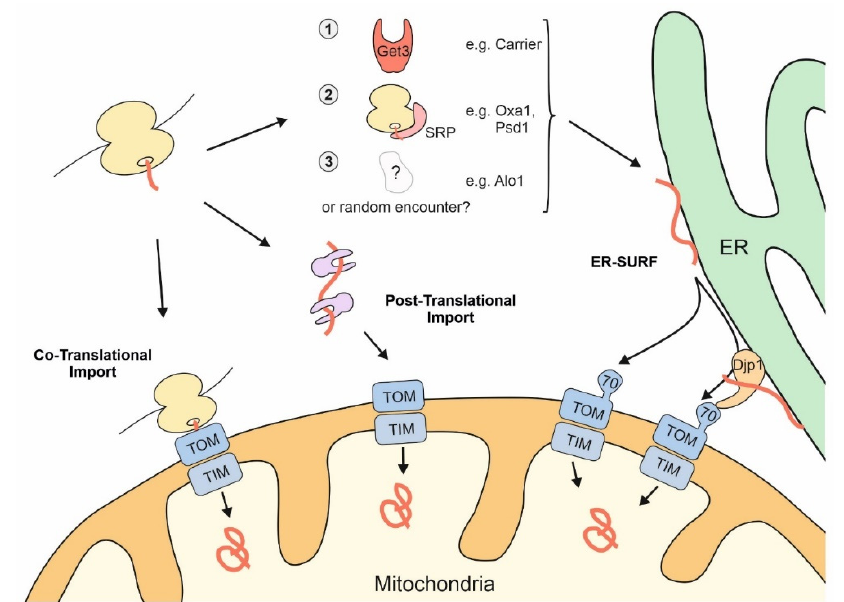
Figure 2. The surface of the ER facilitates mitochondrial targeting of proteins that use the ER-SURF pathway. Precursor proteins can reach mitochondria during, or after, their synthesis on cytosolic ribosomes. Some mitochondrial precursors are directed to the ER surface. For example, metabolite carriers were observed to be bound by Get3, a chaperone that facilitates ER-targeting of TA proteins. Some mitochondrial membrane proteins, such as Oxa1 and Psd1, are recognized by the SRP. For other mitochondrial proteins, such as Alo1, targeting factors were not identified so far. Djp1 is an ER-associated protein that facilitates the transfer of ER-bound proteins to